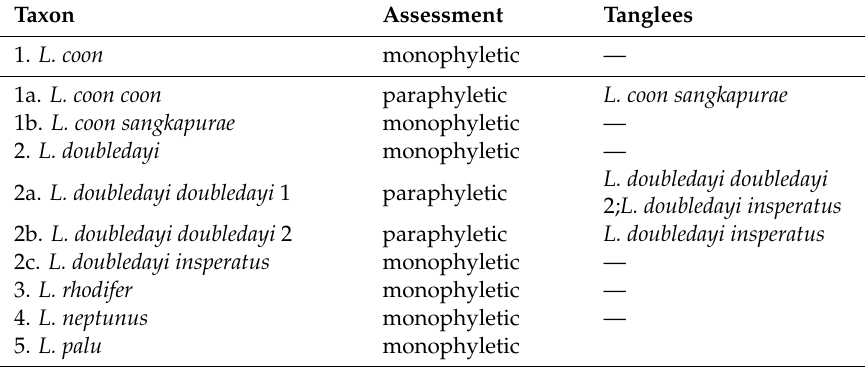
Table 2. Monophylizer assessment of the Losaria species and subspecies used in this study.